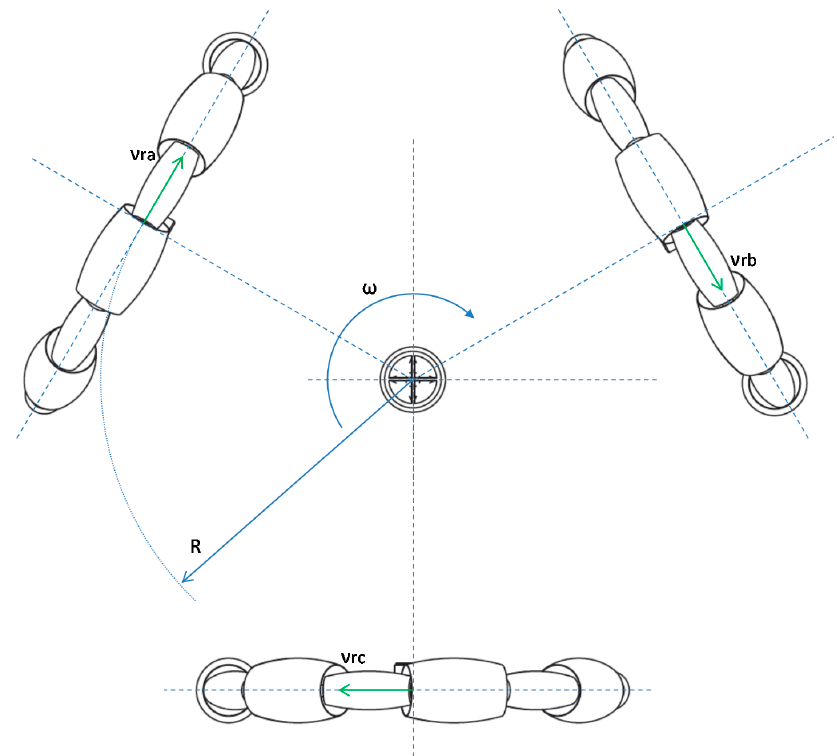
Figure 15. Kinematic diagram of the rotation of the mobile robot: ω is the rotation and v ra , v rb , and v rc are the velocity in each of the wheels caused by rotation motion. R is the distance between the wheels and the center of mobile robot.